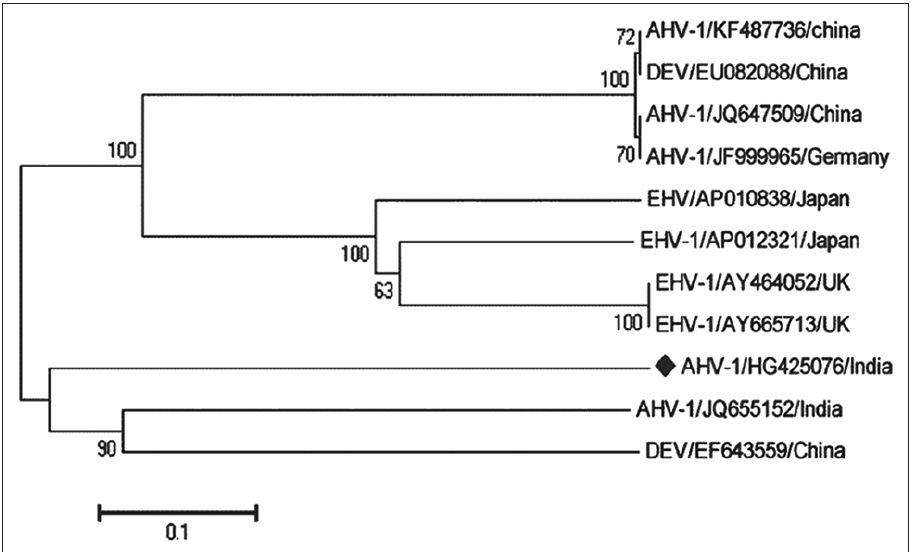
Figure-6: Phylogenetic tree of duck enteritis virus (DEV) isolates HG425076 with other published DEV sequences available in